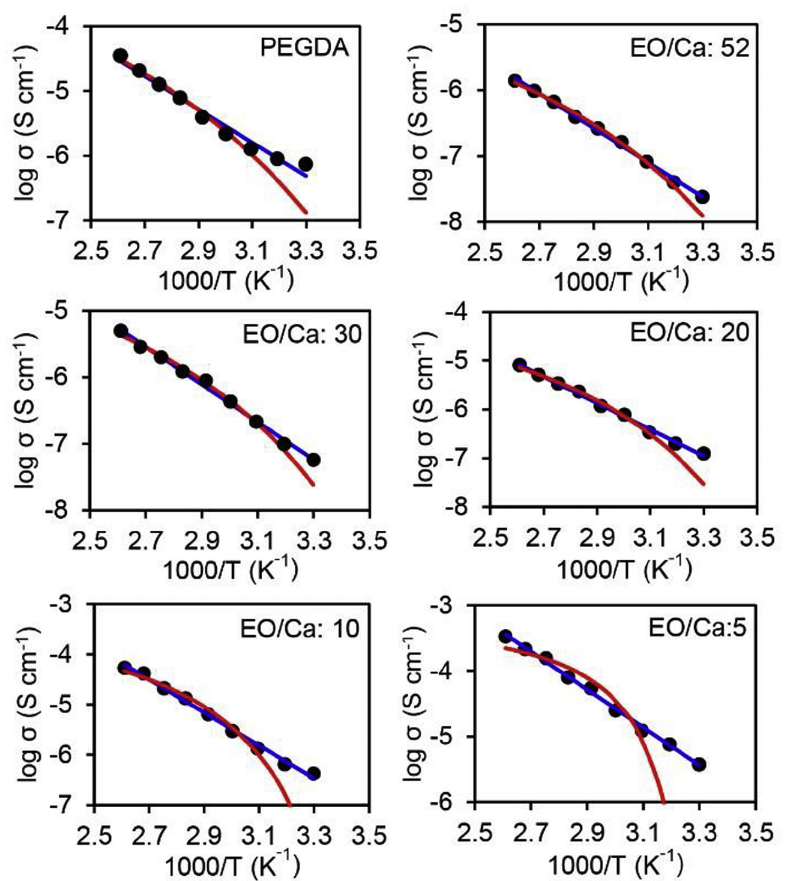
Figure 6. Adapted with permission from reference [196]. Copywrite 2019. Elsevier B.V. Arrhenius plots of PEGDA/Ca(NO 3 ) 2 electrolytes at different ratios of the monomeric unit, ethylene oxide (EO), to calcium